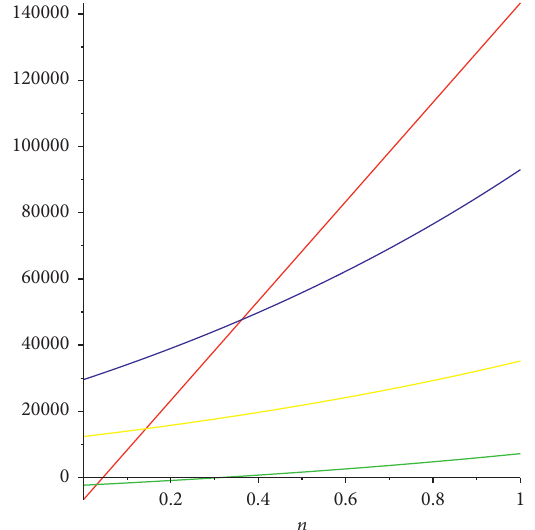
Figure 39: Second hyper-Gourava